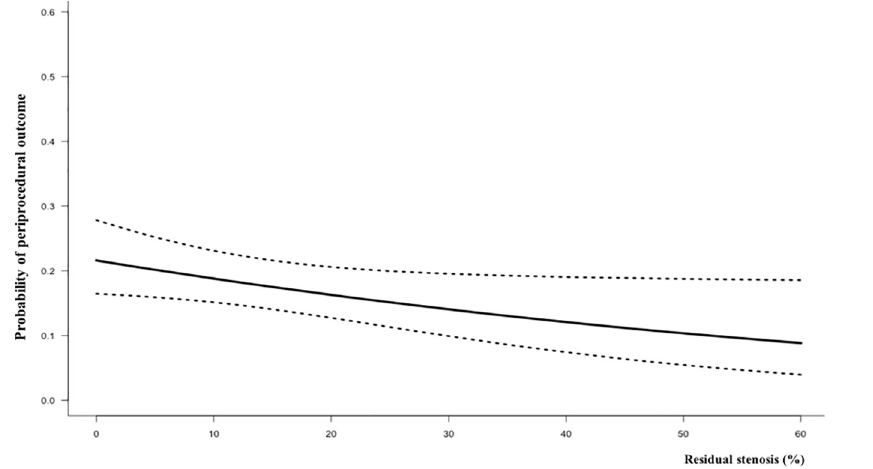
Fig 1. Probability of periprocedural outcome according to the degree of residual